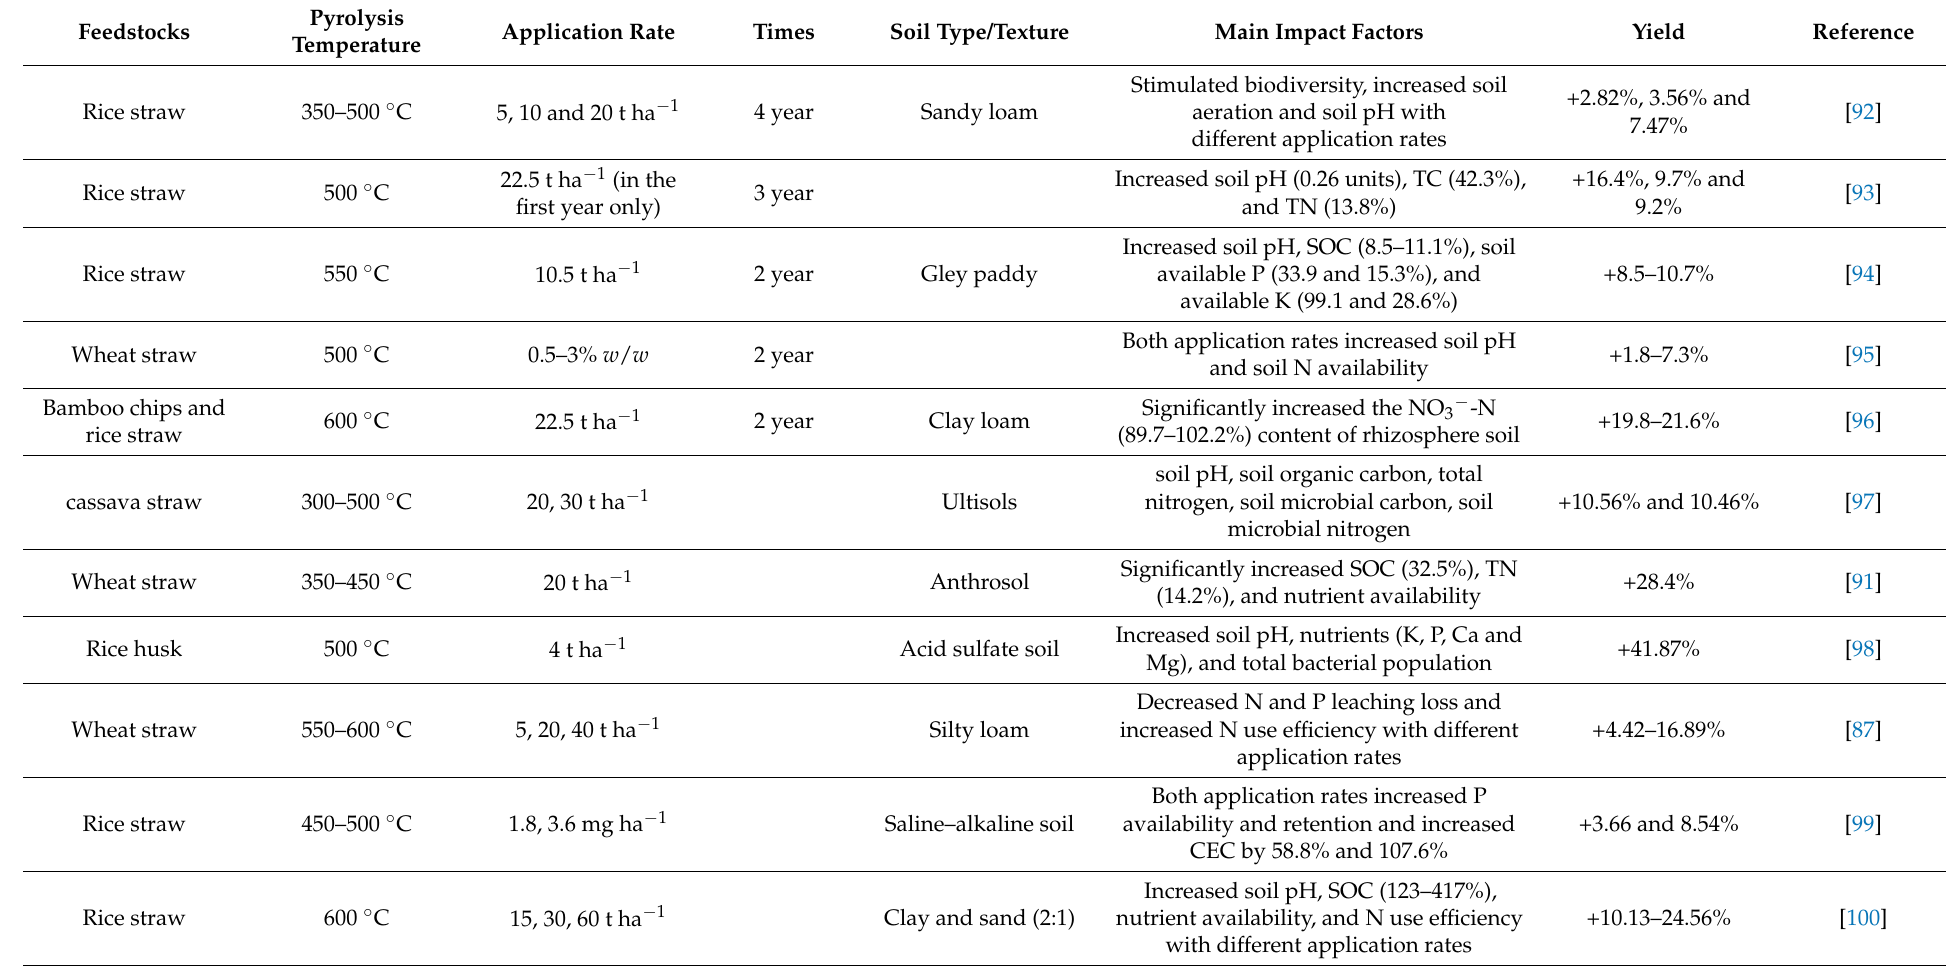
Table 2. Effect of BC application on the improvement of rice